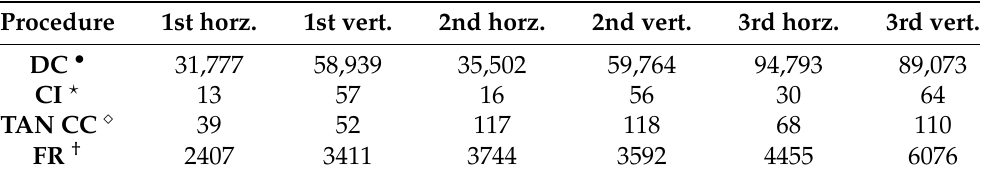
Figure 8. Simplified TAN structure of the Adult dataset. Table 4. Main procedures comparison for each